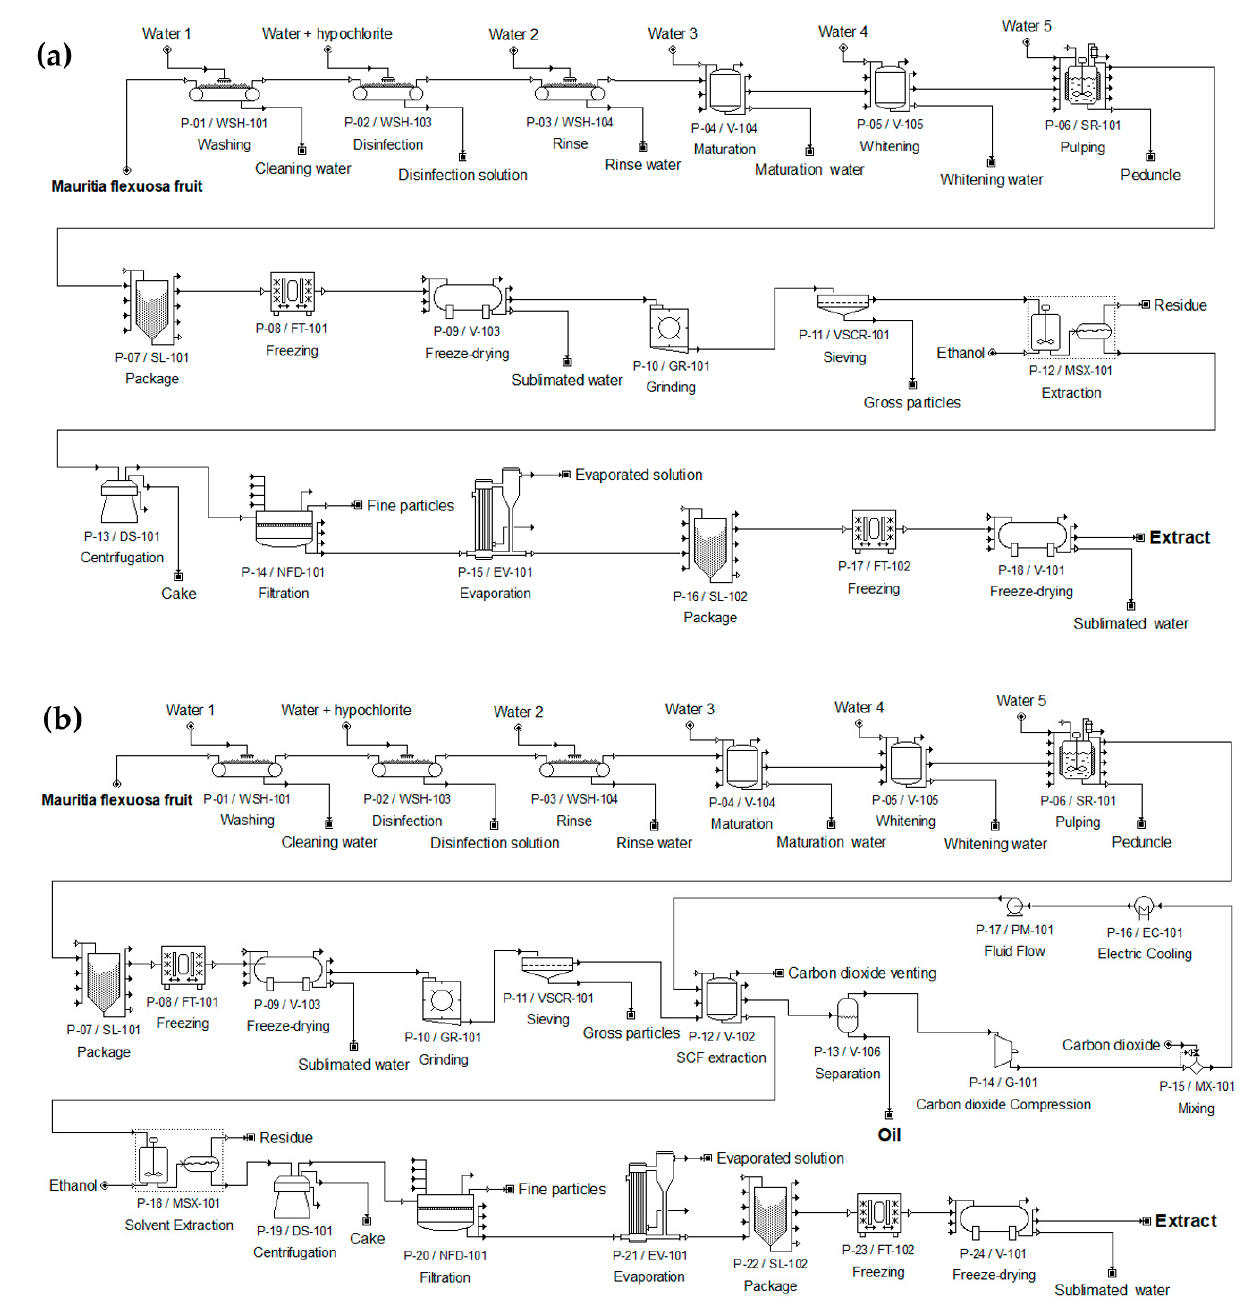
Figure 1. Flowsheets of the ( a ) single ‐ stage process by conventional solvent extraction (CSE) and ( b ) sequential two ‐ stage process using supercritical and conventional solvent extraction (SFE+CSE), designed using SuperPro Designer 9.0 ® software. Source: Ref. [18], reproduced with permission from